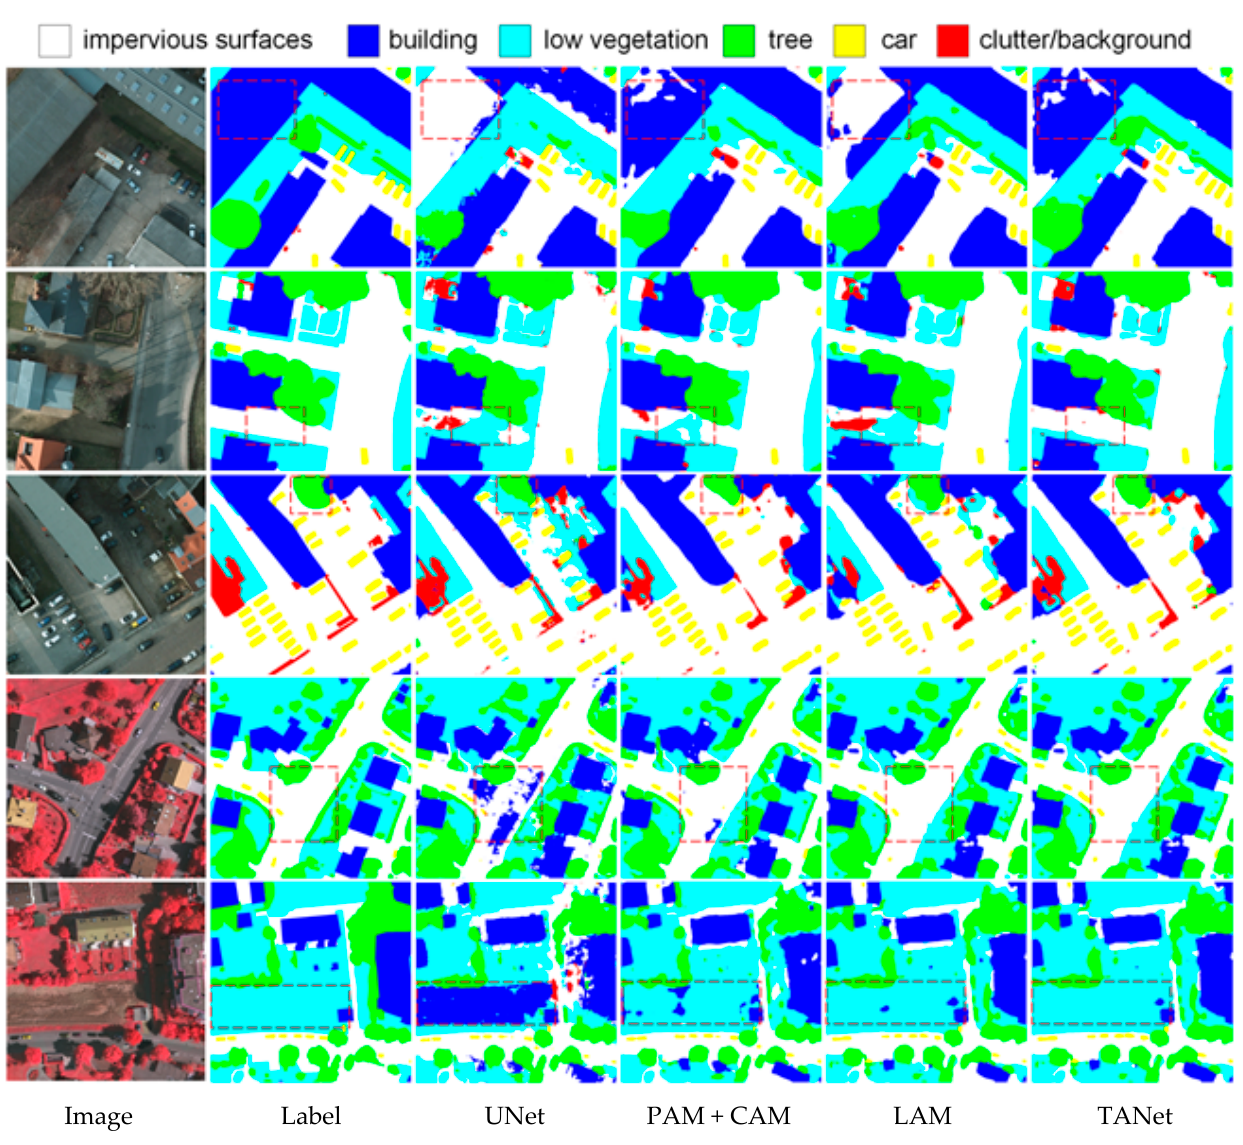
Figure 8. Results on the ablation study of triple attention modules. The first three rows are from the Potsdam dataset and the other is from the Vaihingen dataset.